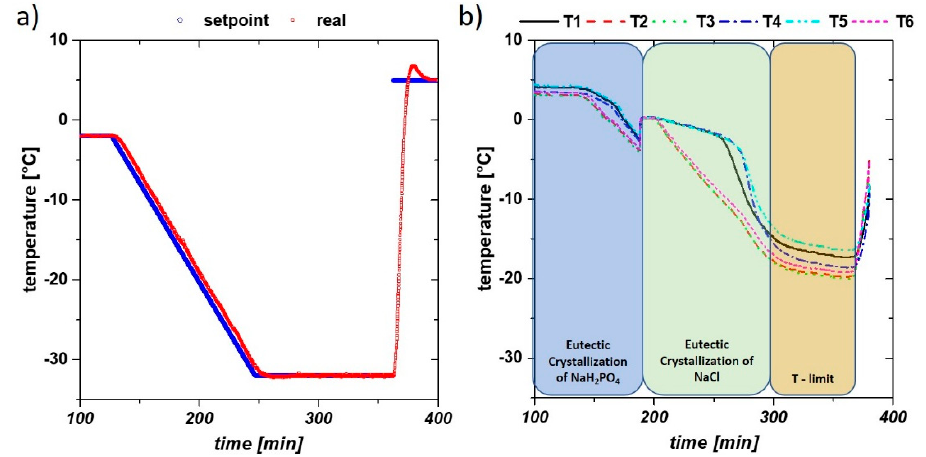
Figure 3. ( a ) Thermostat setpoint and measured temperature at freezing rate of 0.25 °C/min; ( b ) actual temperature of the thermocouples inside the chamber (sketched in Figure 1b), showing inhomogeneous freezing in the chamber. The final temperature had a difference of over 10 °C between thermostat and chamber marked as T limit of the cell.